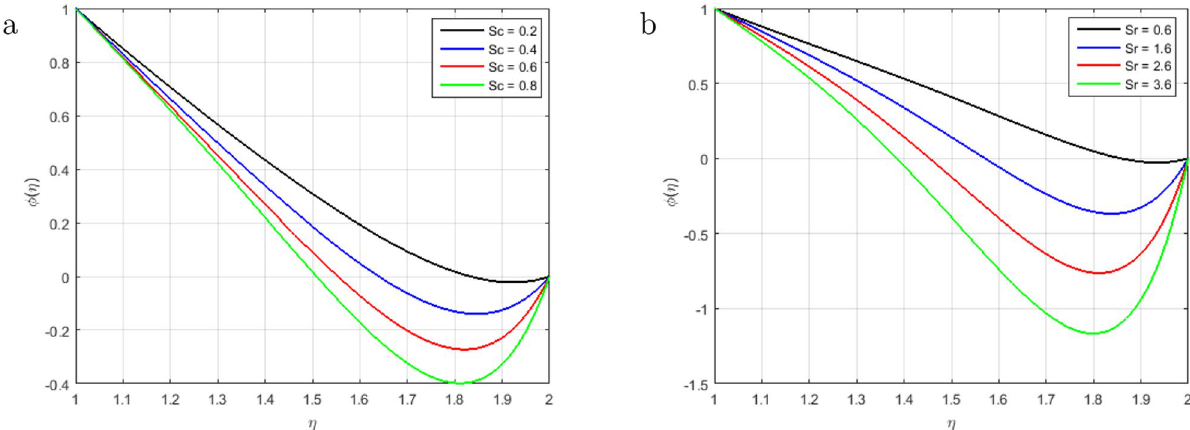
Figure 12. Influence of φ(η) for Sc and Sr and fixed values of S = 2.5, M = 1.4, Pr = 2.2, Re m = 2.5, C 1 = 1.4, Hs = 1.2 .